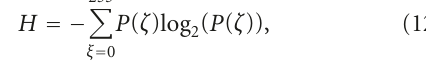
Figure 4: Recognition rate (%) vs. number of training faces for the FERET face database, using proposed FVF and median rule based systems compared with PCA , LDA, LBP, NMF, and